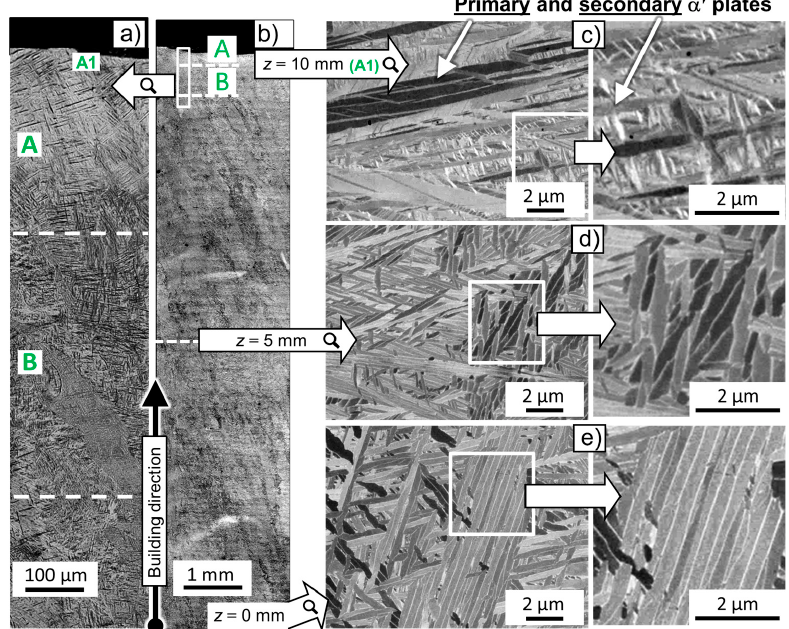
Figure 1. Light optical microscopy (LOM) of ( a ) the upper region and of ( b ) the entire central cross section of a Ti-64 sample along the SLM building direction. Backscattered electron mode-scanning electron microscopy (BSE-SEM) images are shown, corresponding to selected regions of the microstructure for ( c ) z ~10 mm (top); ( d ) z ~5 mm (center) and ( e ) z ~0 mm